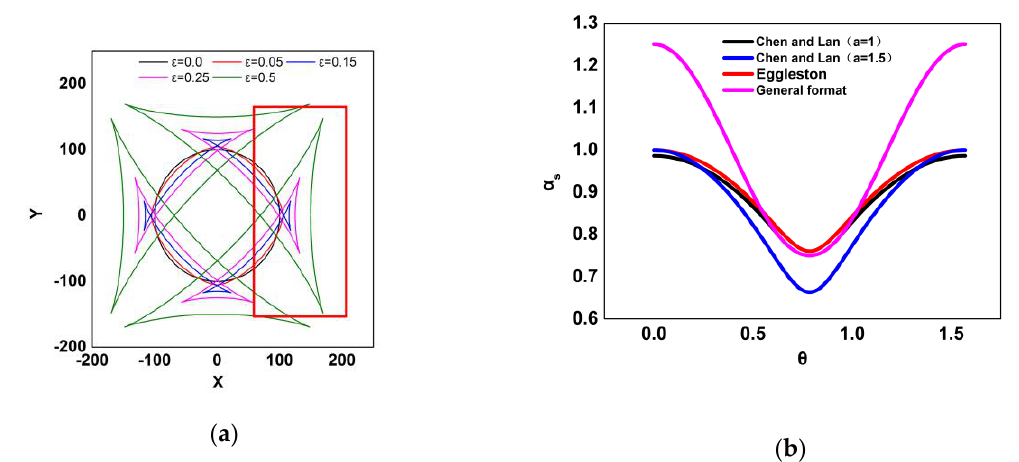
Figure 2. ( a ) Analytical equilibrium shape for different values of ε ; ( b ) the effect of different interfacial anisotropy functions.